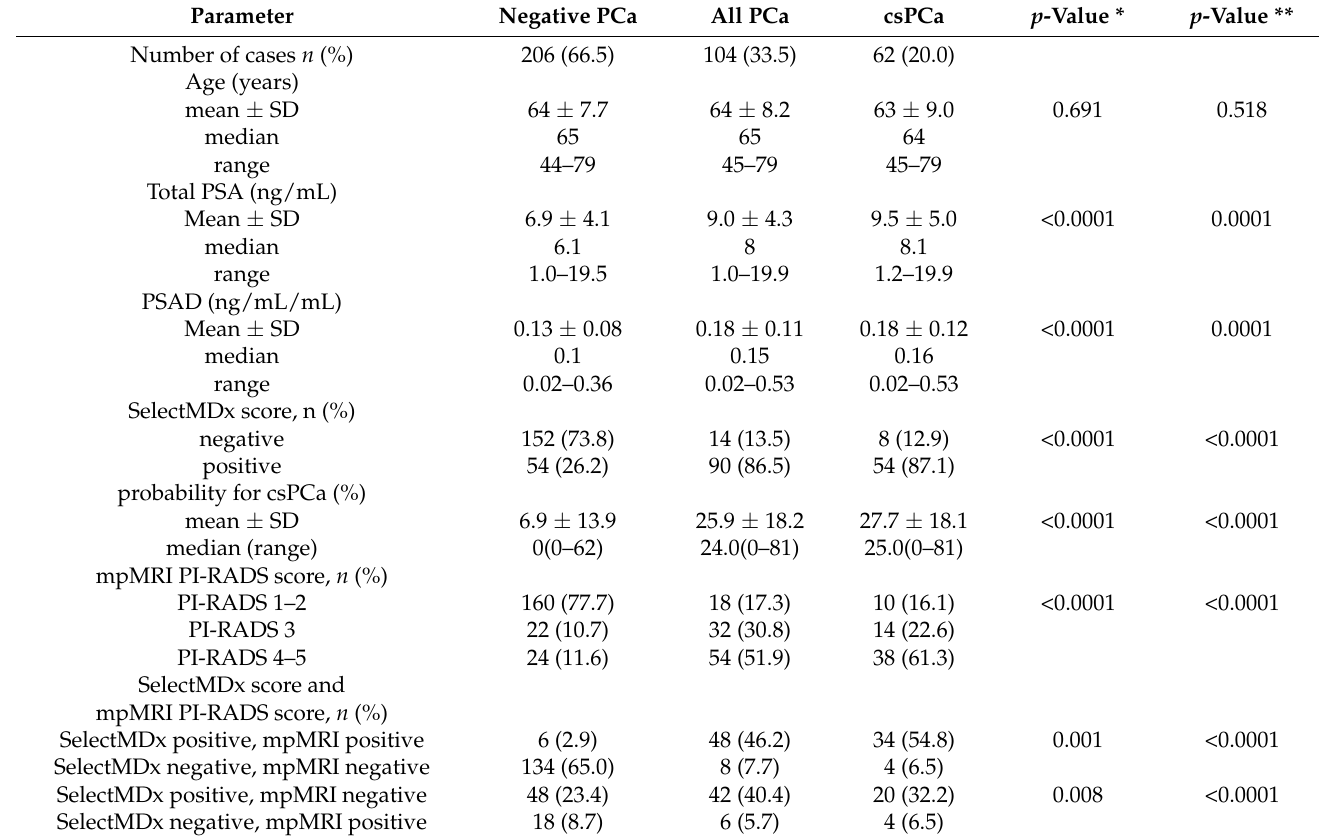
Table 1. Patient characteristics stratified according to prostatic biopsy results (number, %, mean ± SD, median, range). Parameter Negative